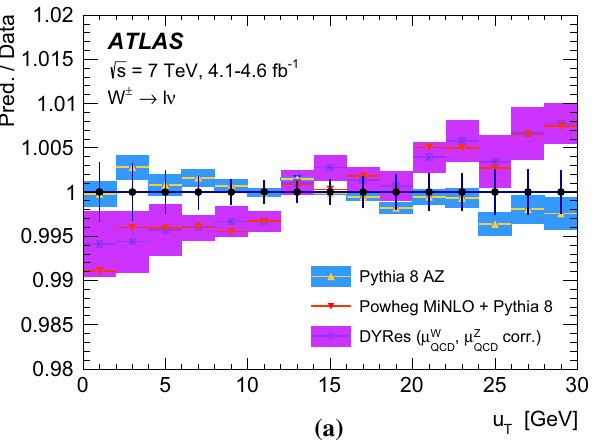
Fig. 22 Ratio between the predictions of Pythia 8 AZ, DYRes and Powheg MiNLO+Pythia 8 and the data for the a u tributions in W → (cid:7)ν events. The W -boson rapidity distribution is reweightedaccordingtotheNNLOprediction.Theerrorbarsonthedata points display the total experimental uncertainty, and the band around